Question: What does this figure show? Answer in one sentence.
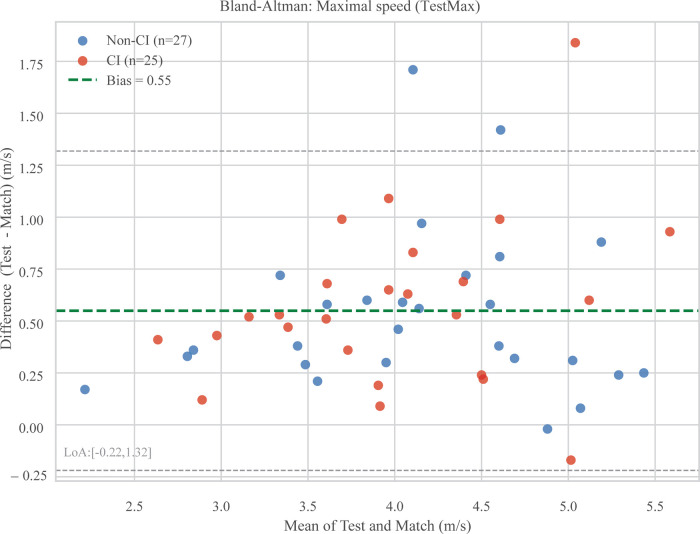
Answer: Test-match discrepancies for representative test parts from the domains of maximal wheelchair speed (TP4) and acceleration per push (TP2). Boxplots illustrate the distribution of per-athlete discrepancies for athletes with coordination impairment (CI) and without coordination impairment (Non-CI), with individual data points overlaid. Positive values indicate higher test performance relative to match performance. Additional results are provided in the Supplementary Materials .